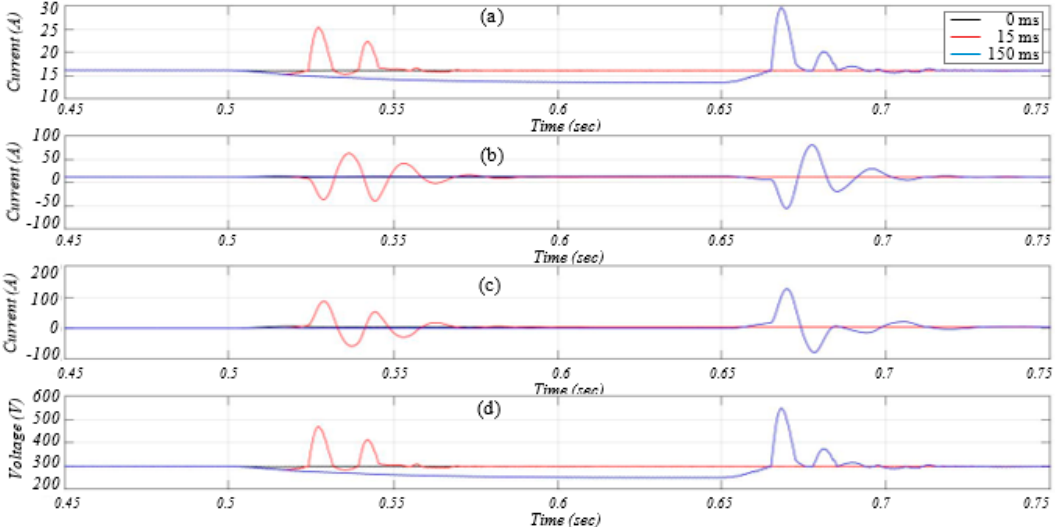
Figure 10. Impact of delay on the bidirectional converter switch S bi , C T = 4800 μ F and I m = 7.1 A: ( a ) in grid-tie, ( b ) with a 15 ms delay, and ( c ) with a 150 ms